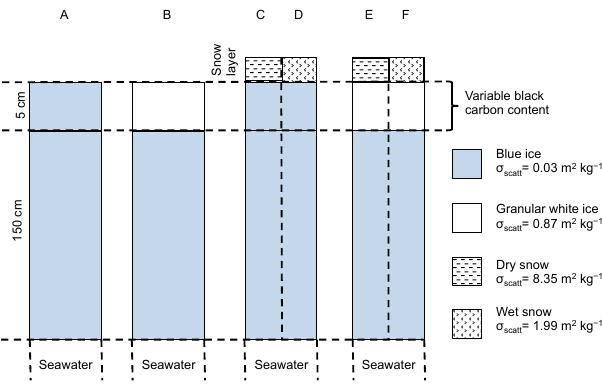
Fig. 1. Sea ice and snow configurations modelled (not to